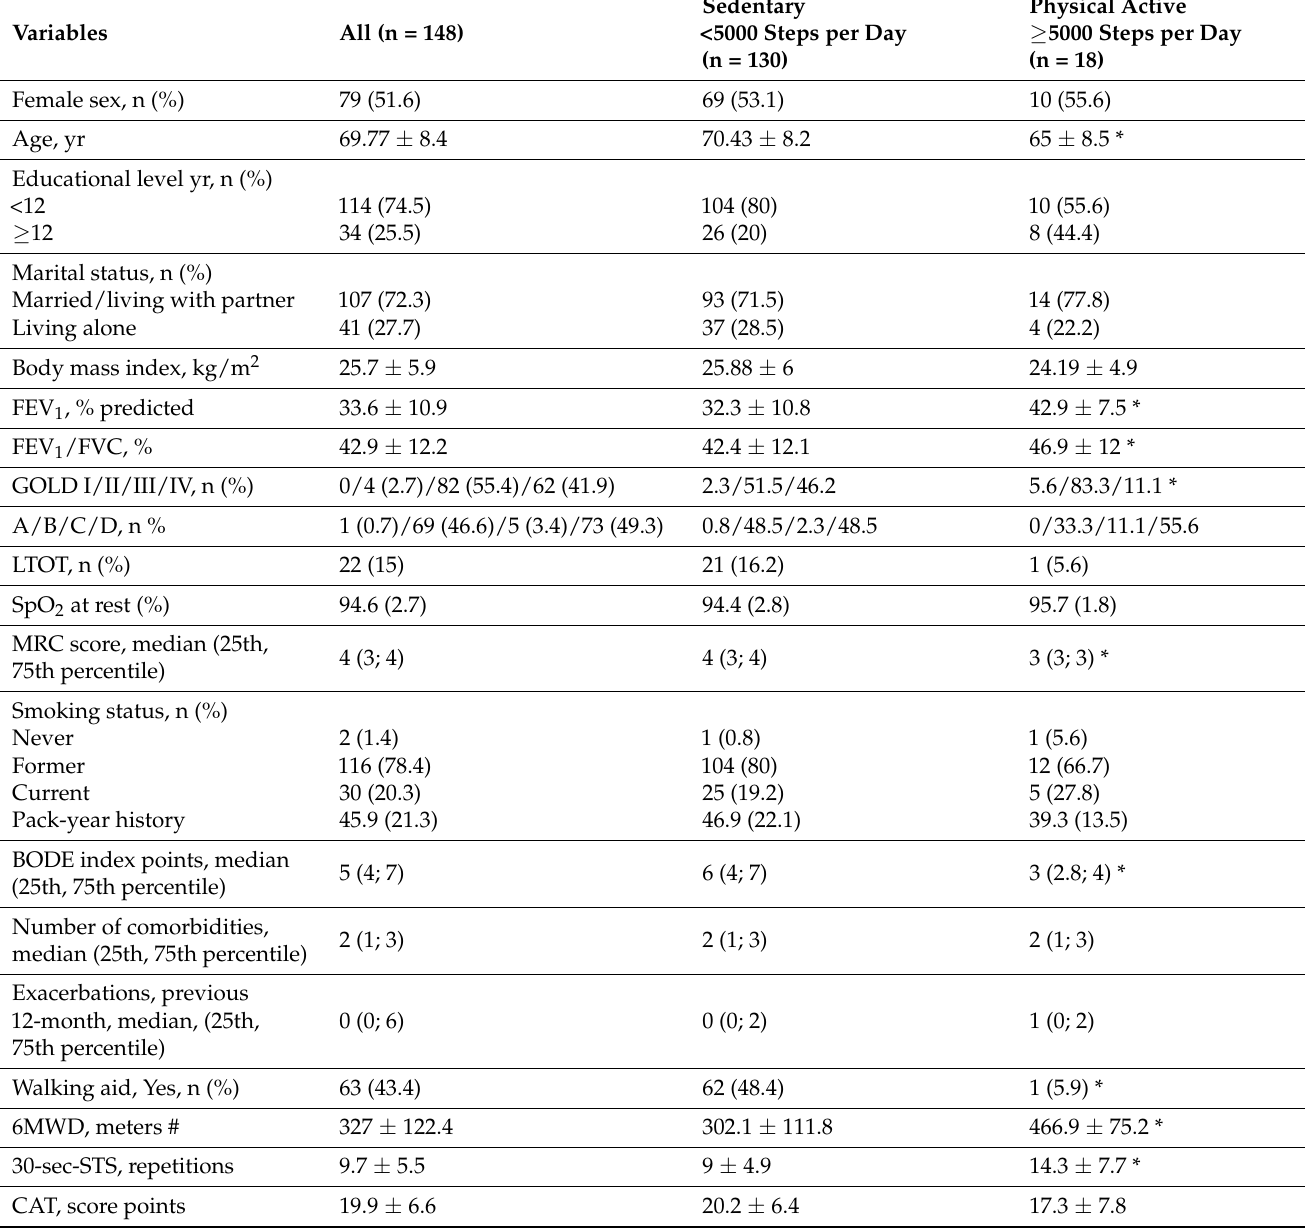
Table 1. Characteristics of included